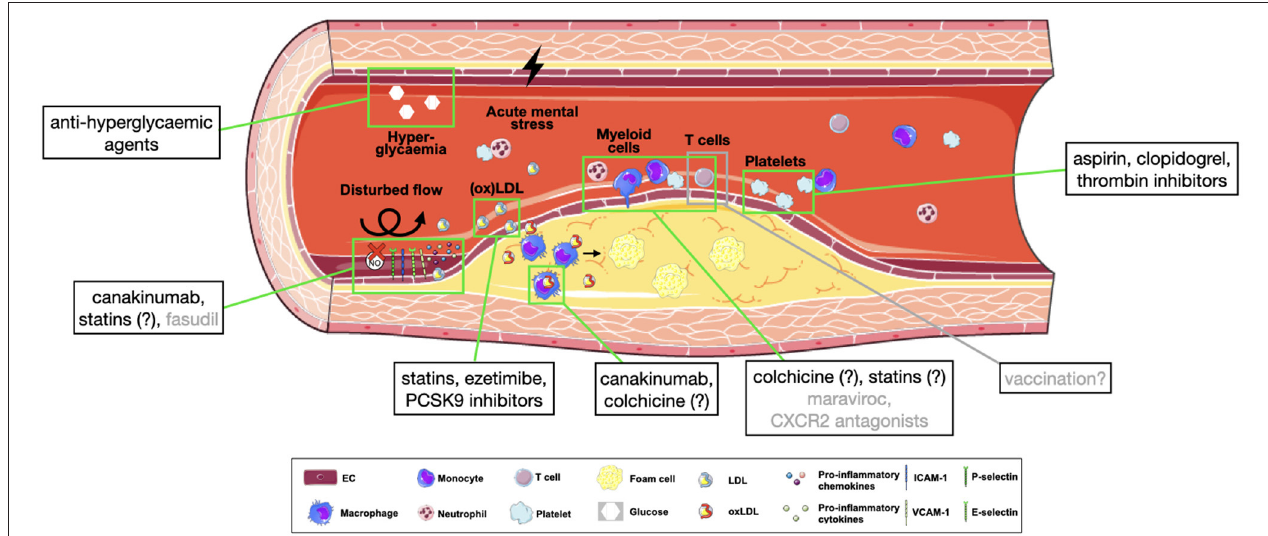
FIGURE 2 | Pharmacological targets in atherosclerotic leukocyte recruitment. Simplified overview of approved (black) or potential (gray) targets in the process of leukocyte recruitment into atherosclerotic plaques. Substances with an incompletely clarified mechanism of action are marked with (?). CXCL2, C-X-C